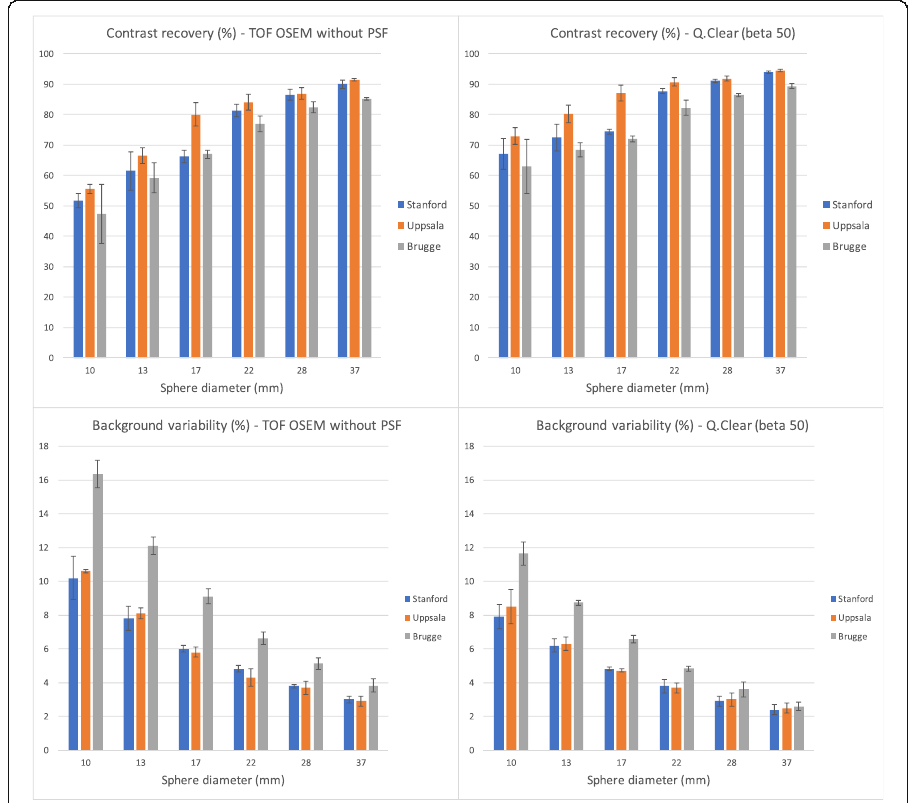
Fig. 5 Contrast recovery and background variability. Contrast recovery data are given in the upper panels and background variability in the lower panels. Data are represented for TOF OSEM reconstruction without PSF correction in the left panels and for Q.Clear reconstruction (beta = 50), including PSF correction in the right panels. Data on the MI 4 systems in Stanford and Uppsala are taken from [3]. Error bars represent one standard deviation, as determined from 3 repeat